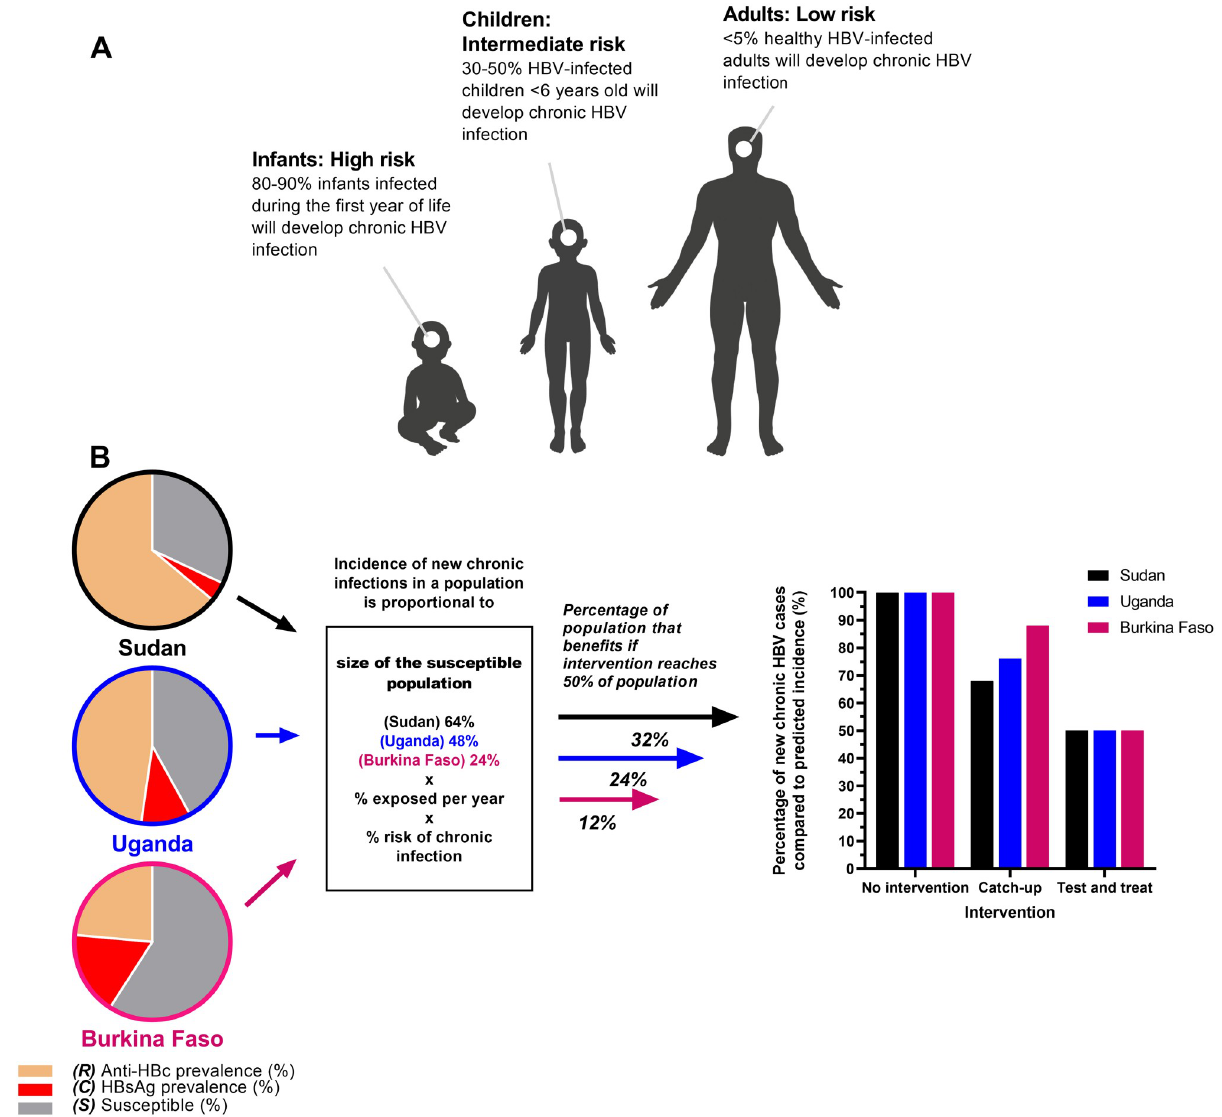
Fig 7. Cartoons to illustrate seroepidemiology of HBV infection in Africa and the differential impact of HBV interventions according to population targeted. (A) After exposure to HBV, the risk of developing CHB is highest among young infants, and this risk gradually declines with age until adulthood, when there is low risk of developing CHB. Figure informed by parameters in S1 Table. Artwork supported by figures created with BioRender.com. (B) Populations from Sudan [39], Uganda [3], and Burkina Faso [40] represent approximately the 25th, 50th, and 75th percentiles in the data set collected from our literature review. In adults, assuming that different populations are exposed at the same rate and the risk of CHB is constant (estimated to be 5% in healthy adults as shown in panel A), the incidence of new CHB infection in the population is related to the proportion S . Without intervention, 100% of predicted new cases will occur. If 50% of the adult population is vaccinated in a catch-up campaign, CHB will be prevented only among the population S . The impact of catch-up vaccination on incidence is therefore related to S , with reduced impact in highly exposed populations. In a T&T scenario, with 50% of cases identified and treated, incidence is consistently reduced, regardless of S . anti-HBc, antibody to hepatitis B core antigen; C , HBsAg prevalence; CHB, chronic hepatitis B; HBsAg, hepatitis B surface antigen; HBV, hepatitis B virus; R , anti-HBc prevalence; S , susceptible population; T&T, Test and